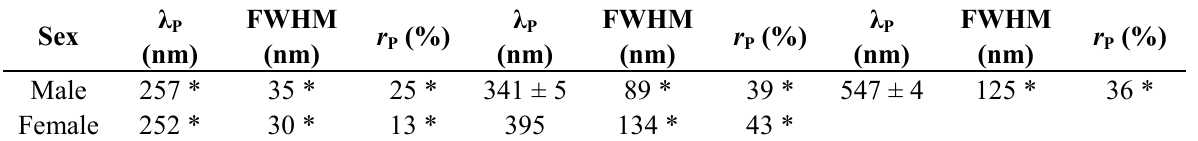
Table 2. Wavelength λ , FWHM and reflectance r of the peaks on the reflectance spectra, P P which were measured for the iridescent wings of the male and female C. ataxus butterflies by Imafuku et al .